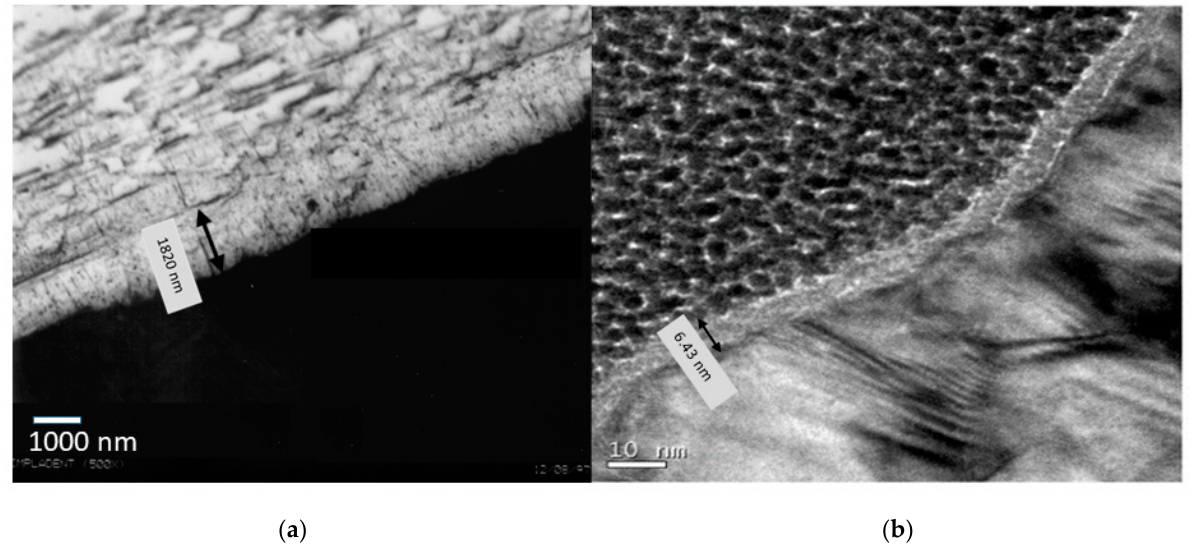
Figure 1. Passivation film obtained by acid etching: ( a ) hydrochloric acid and ( b ) citric acid. Interferometric 3D-roughness of the different Ti samples are shown in Table 2. The differences were quantified by calculating the roughness parameters Sa, Sm and index area. As shown on Figure 2, the results of the roughness measurements confirmed a statistically-significant ( p < 0.05) increase of the roughness when the samples are etched by acid in both cases. Hydrochloricacid is more concentrated, consequently the roughness is bigger than that of citric acid. The same trend is shown by the spacing parameter Sm. The index area parameter indicates the increase of real area compared to the nominal area of the sample due to roughness. As expected, the higher roughness leads to a higher index area. Table 2. Roughness parameters of the titanium treated samples.